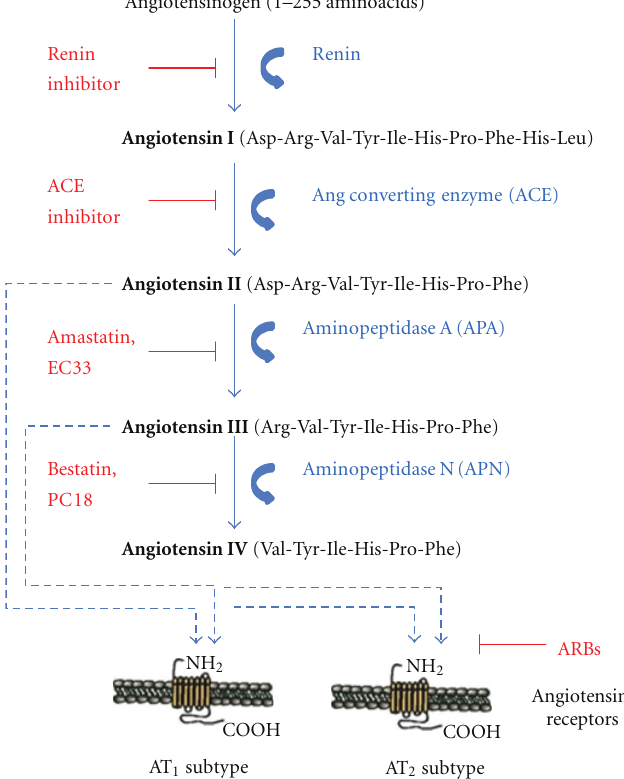
Figure 1: The renin-angiotensin pathway including active ligands (bold), enzymes, receptors, and inhibitors involved in central angiotensin mediated blood pressure. Abbreviations: ACE: angiotensin converting enzyme; APA: aminopeptidase A; APN: aminopeptidase N; ARBs: angiotensin receptor